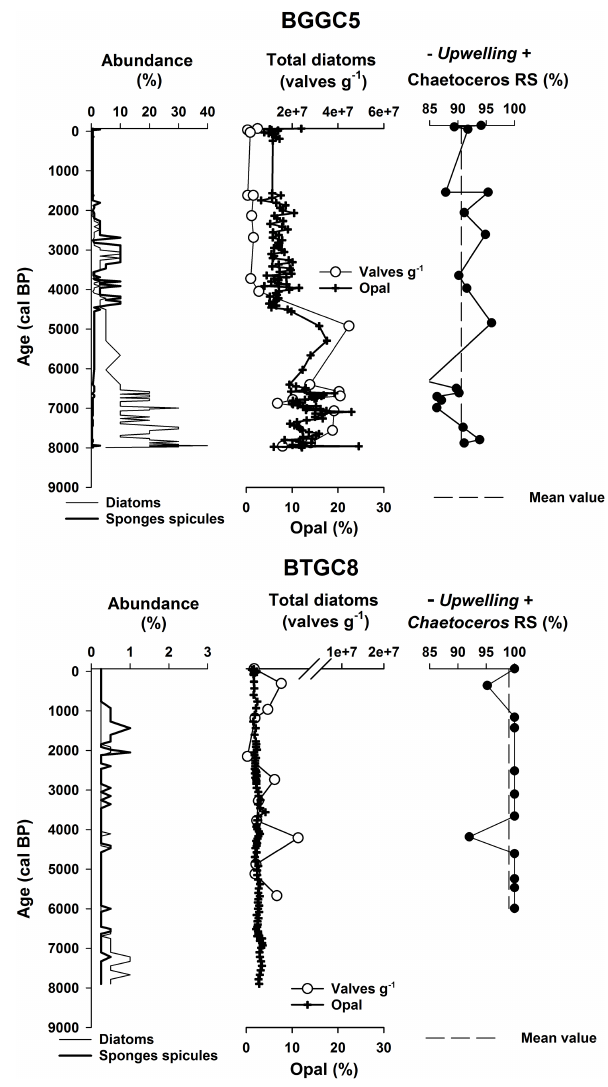
Figure 6. Diatom and sponge spicule relative abundances, total di- atom counts (valves g − 1 ) and opal (%), and downcore variations in Ch. RS percentages as proxies of upwelling intensity in cores BGGC5 and BTGC8 (Guanaqueros and Tongoy Bay, respectively). The dashed line represents the average of Ch. resting spores for the respective